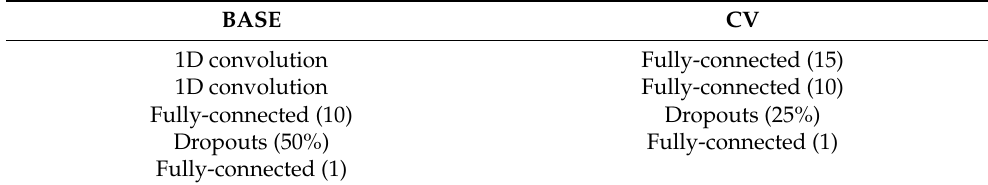
Table 4. Architecture of DNN models. The numbers in brackets represent the number of neu- rons used in the fully connected layers. The percentage in brackets represents the percentage of dropped